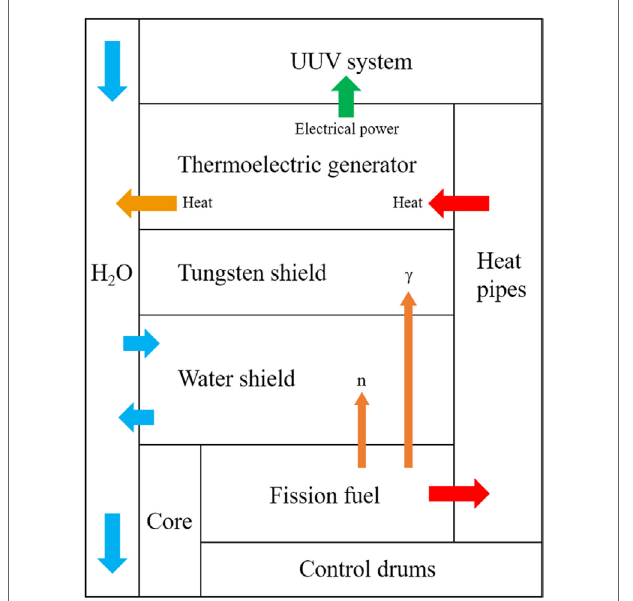
FigUre 1 | Flowchart of the nuclear power source.